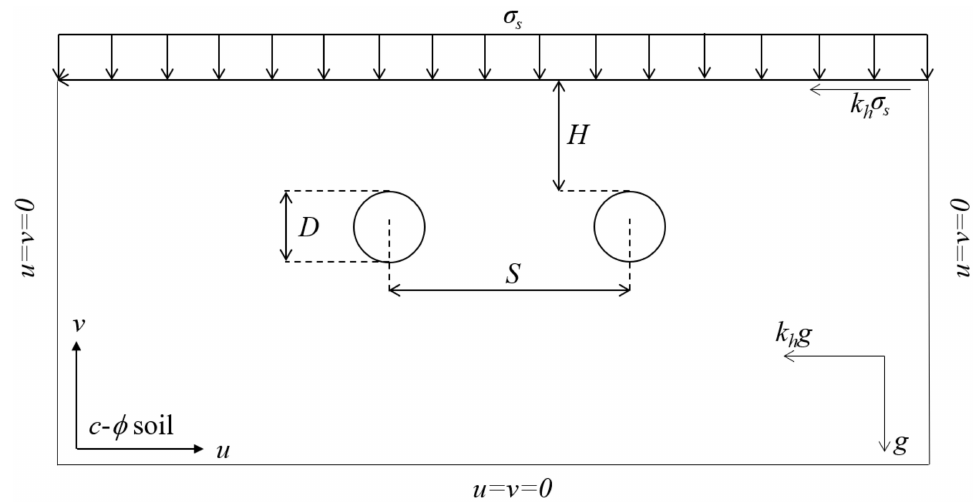
Figure 1. Problem